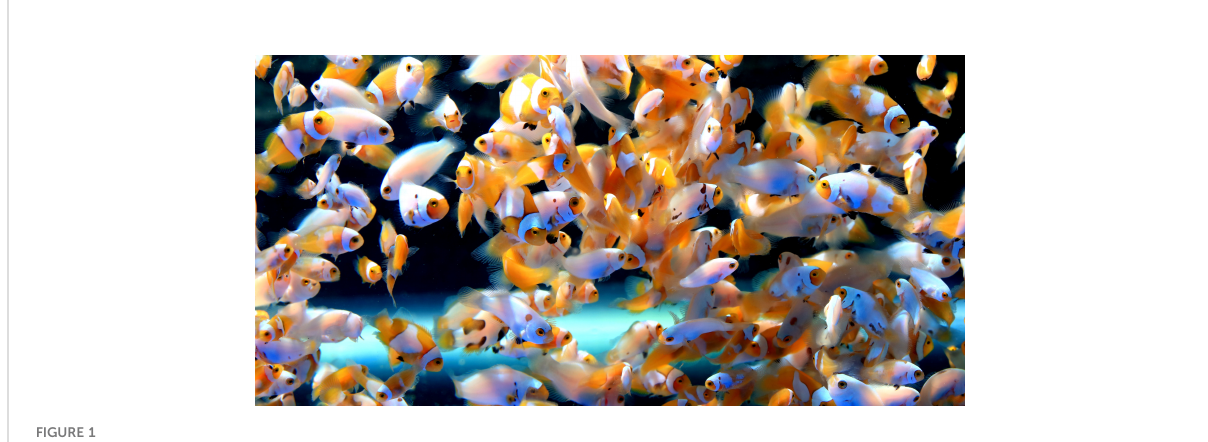
FIGURE 1 Designer clown fi